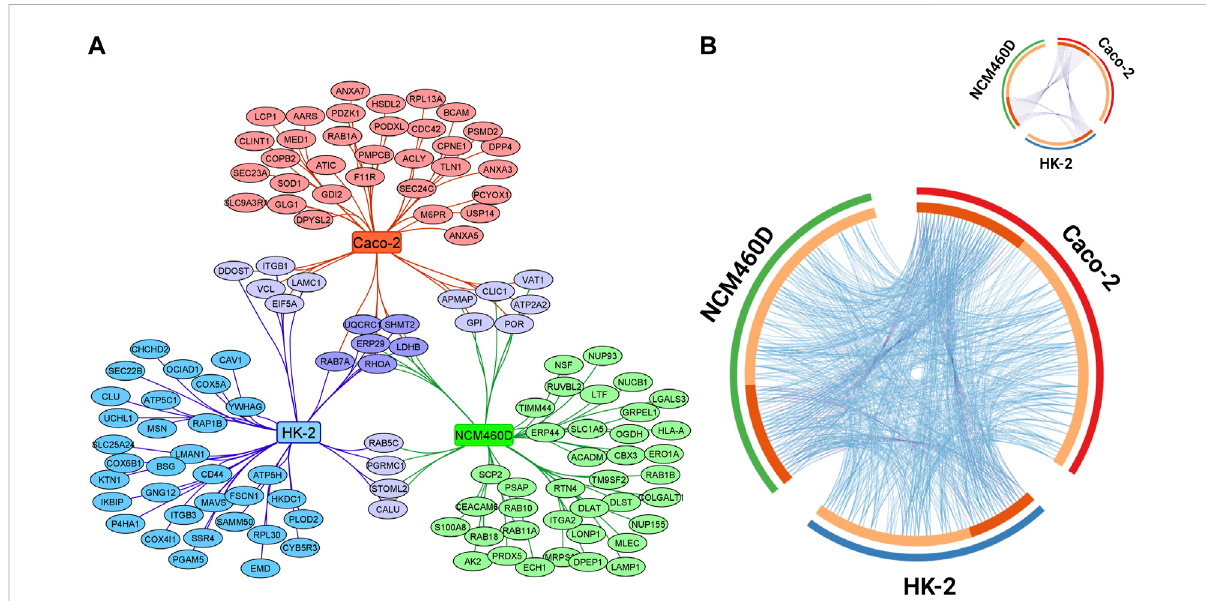
FIGURE 3 VisualizationofthedatasetsobtainedbyS1pulldowninHK-2NCM460D,andCaco-2cells. (A) Genesspeci fi cforHK-2,NCM460D,andCaco-2 are depicted in the graph as blue, green, and red nodes, respectively. The shared proteins are reported as violet circles. (B) Circos plot representing the overlap between gene lists at the gene and GO level is reported. Purple curves link identical genes and are represented in the insert fi gure. The innercirclerepresentsgenelists,wherehitsarearrangedalongthearc.Genesthathitmultiplelistsarecoloredindarkorange,andgenesunique for a list are shown in light orange. Blue lines link genes that belong to the same enriched ontology